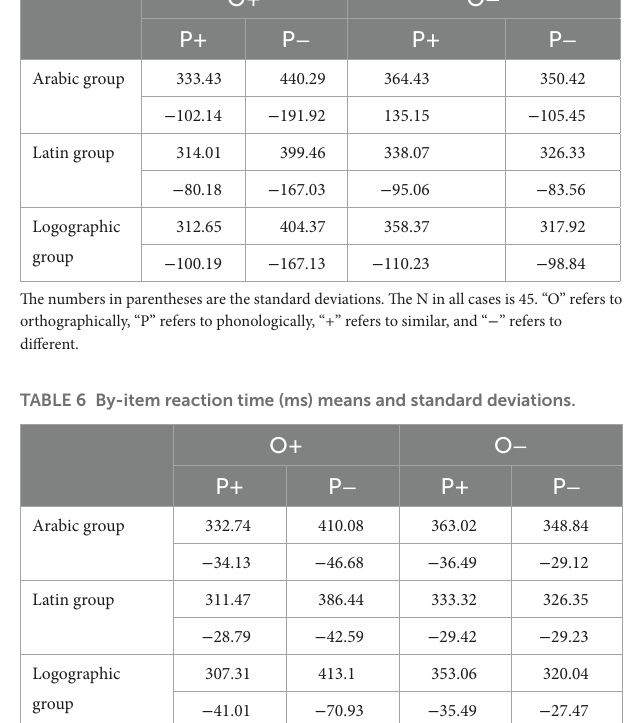
Figure 3 for a visualization of the results. There were no separate